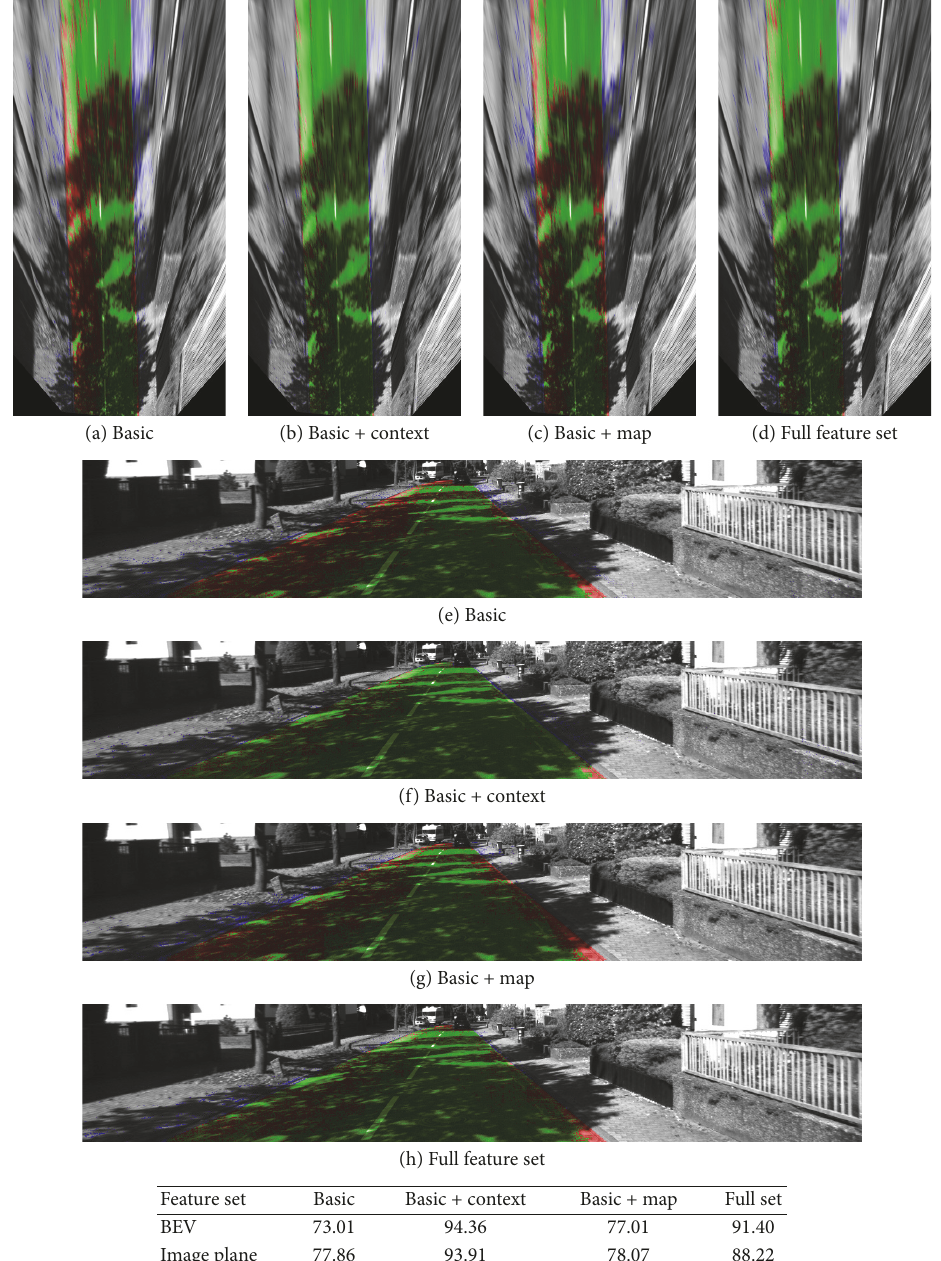
Figure 18: Results of unary terms in a specific UM image. The combination basic + context fits very well the real shape of the road in UM. Consequently, when the map prior is included in the feature set, the classifier interprets part of the prior information as noise or unreliable data in the final